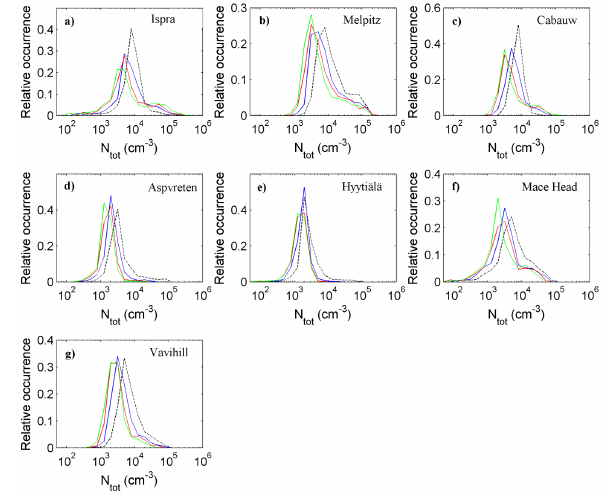
Fig. 5: Total number concentration probability distribution curves for May 2008 (black dashed lines), the baseline 2030 scenario (blue lines), the MTFR 2030 scenario (red lines), and the MCE 2030 scenario (green lines). The concentration bins are logarithmically equally distributed in the concentration axes (10 bins per decade).